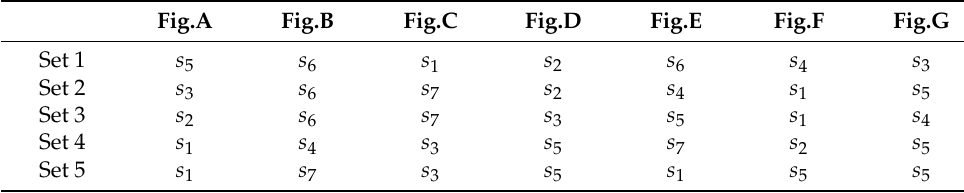
Table 1. Answers for calibration experiment of DM 1 .